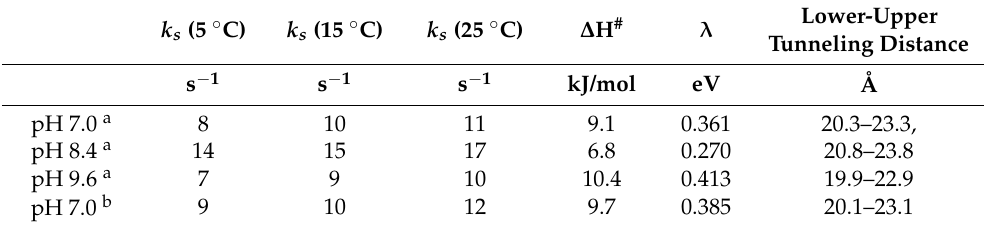
Table 3. Kinetic constants, k s (s − 1 ), for immobilized Streptomyces coelicolor small laccase (SLAC) at selected pH values and temperatures, together with activation enthalpies and reorganization energies for heterogeneous ET between the immobilized enzyme and the electrode.